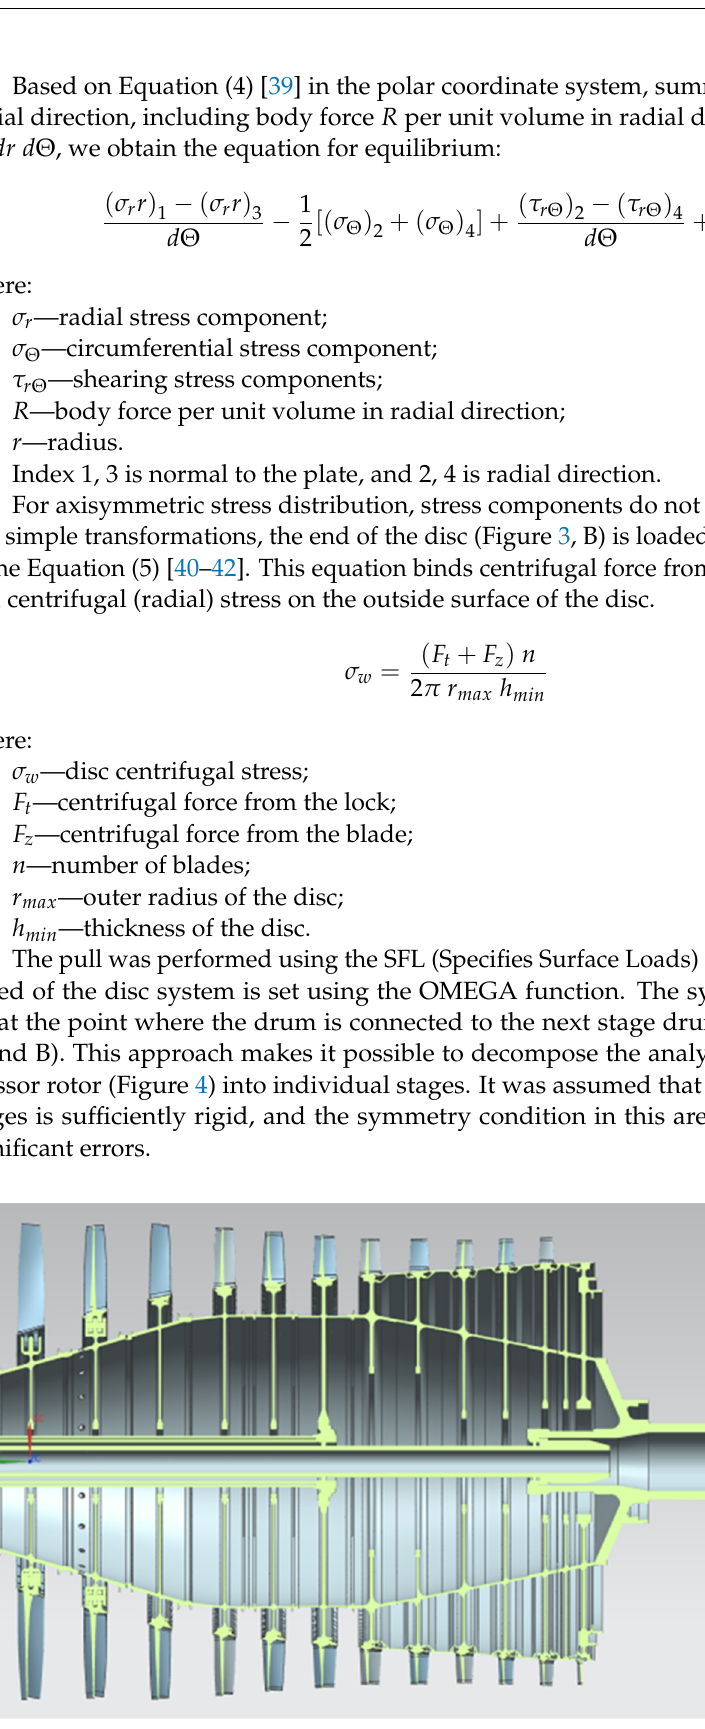
Figure 4. Compressor optimisation rotor.